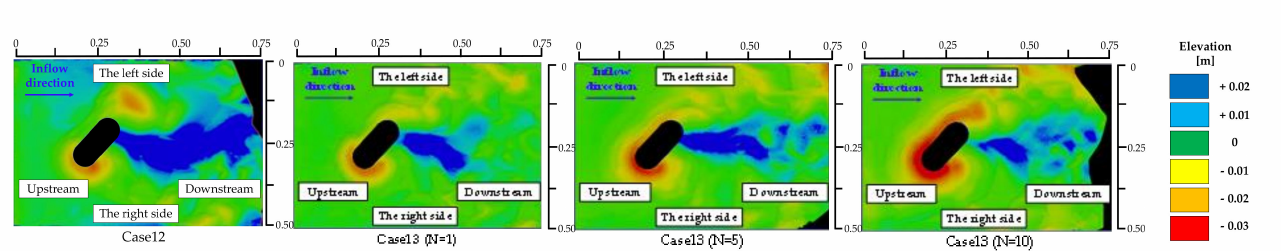
Figure 5. Local scour depth after the experiment for Cases 12 and 13. ( θ = 45 ◦ , H 1 = 0.075 m, T = 600